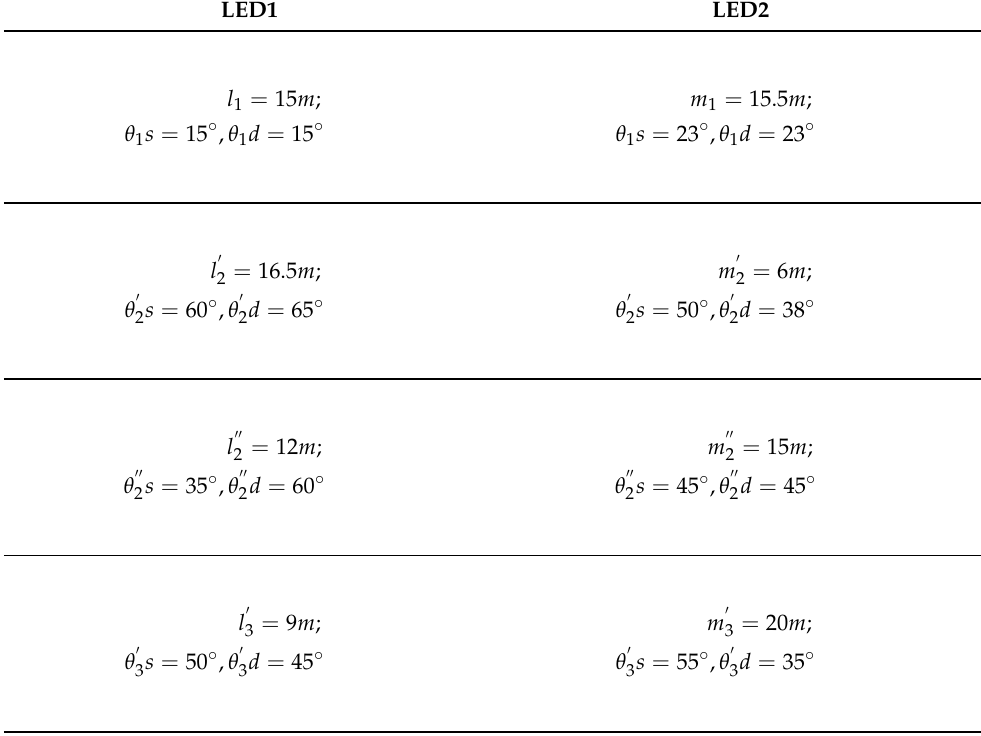
Table 2. Parameters used in the dual LED NLOS propagation model. LED1